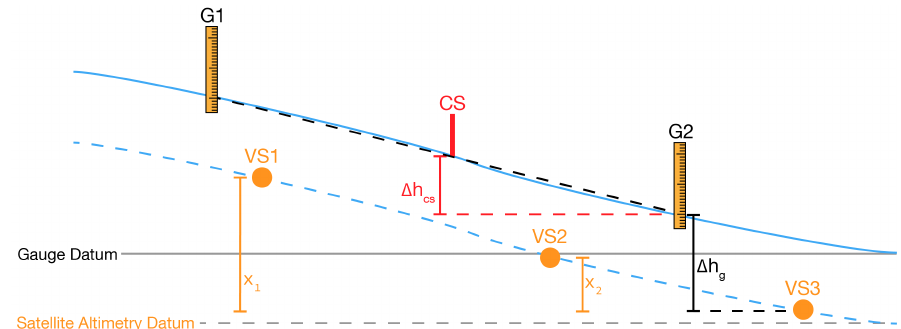
Figure A1. Illustration of the determined elevations showing three virtual stations (VS1-3), two gauges (G1 and G2), and a cross-section (CS) along a river (blue). The dashed blue line shows the river relative to the satellite altimetry datum. The elevations x 1 and x 2 above the reference station VS3 are the results of a linear adjustment of the satellite altimetry data. x 1 and x 2 are subtracted from measurements at VS1 and VS2 respectively to combine all VS to one long-term time series. The two offsets ∆ h g and ∆ h cs are necessary for the validation of the cross-sectional geometry with bathymetric survey data to compensate for the different datums and the shift in